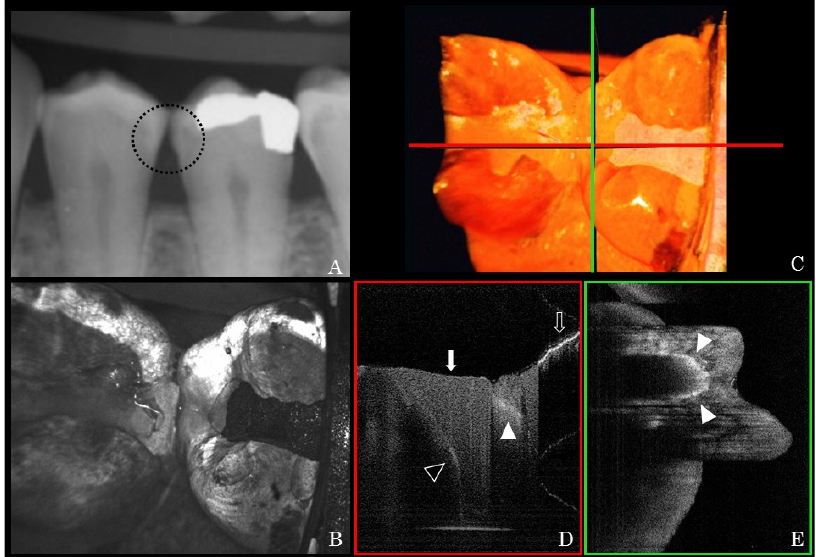
Figure 4. Representative bite-wing X-ray image of lower left premolars ( A ) and the corresponding OCT XY en-face image at the similar area ( B ). Mesial-distal and buccal-lingual cross-sectional images ( D , E ) at horizontal and vertical lines on the 3D image ( C ) were reconstructed from the OCT raw data. In the mesial-distal cross-section ( D ), in contrast to the bright line at the occlusal surface of amalgam restoration (blank arrow), OCT laser was able to penetrate into the resin composite restoration (bold arrow) and show the interfacial gap formation (blank arrow head). The high signal intensity at the mesial part of the second premolar, which indicates proximal caries, could be observed in the buccal-lingual cross-section at the distal proximal part ( D , E bold arrow heads). This pattern of light scattering within proximal enamel suggests a cavitated proximal caries lesion, or a moderate caries lesion. The round pattern internal scattering resembles the boundaries of enamel surface breakdown.